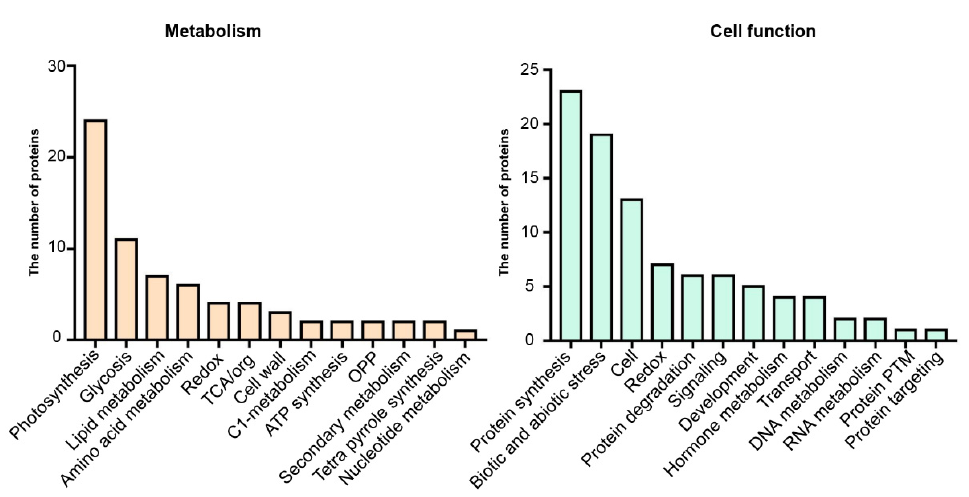
Figure 4. Functional classification of the fluid proteins using MapMan software. Identified fluid proteins were annotated as metabolism and cell-function categories.